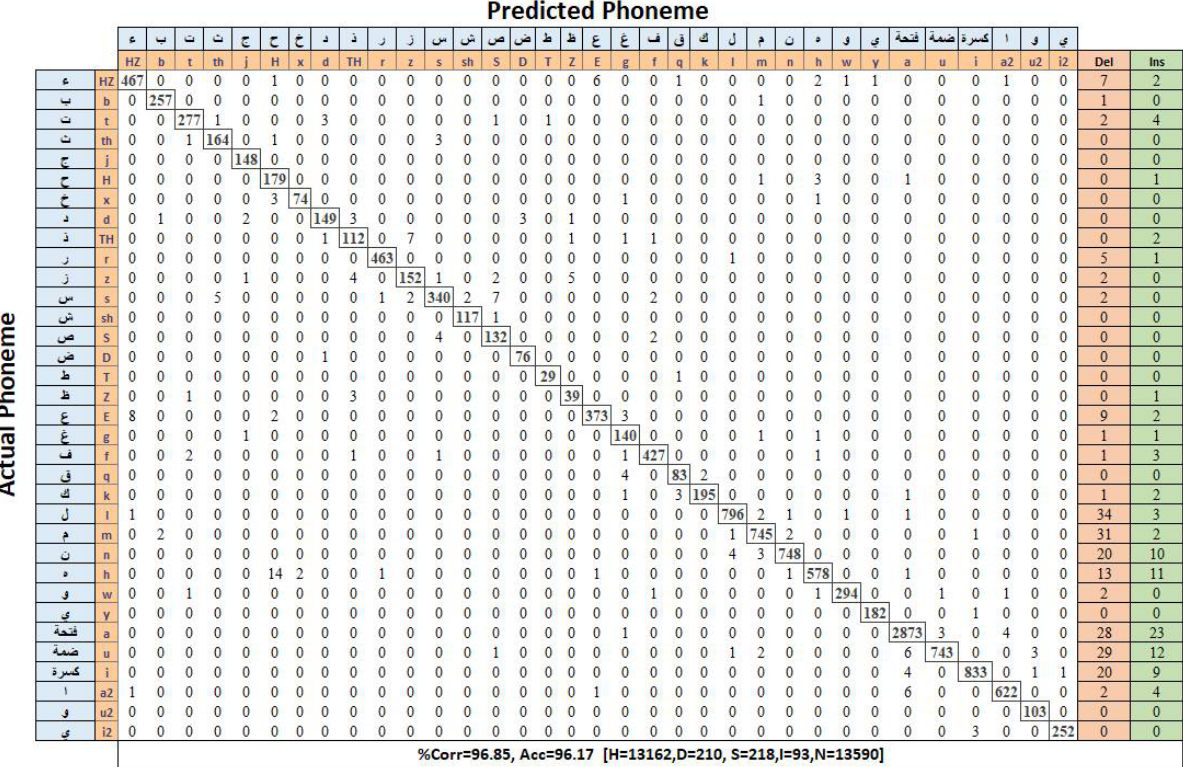
Figure 5. Confusion matrix of the phoneme detection task using the YOLO-CNN-RNN-CTC model.